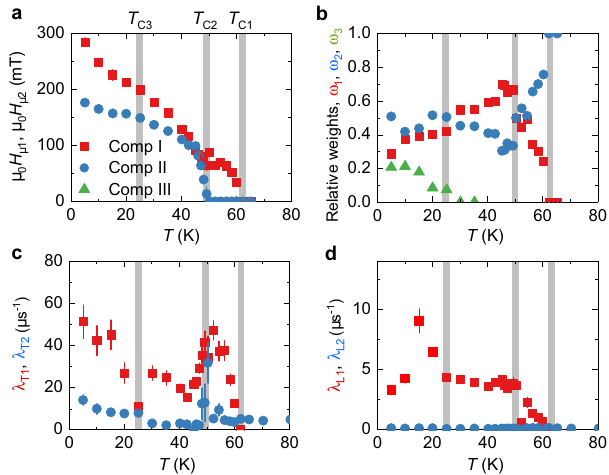
Fig. 2 Temperature dependent μ SR parameters. a The temperature dependence of the internal magnetic fi elds for the observed two components in CrI 3 . b The temperature dependence of the relative weights ω 1,2,3 of the three components in the total signal. c , d The temperature dependence of transverse depolarization rates λ T 1 , λ T 2 and the longitudinal depolarization rates λ L 1 , λ L 2 for two components, respectively. The error bars represent the standard deviation of the fi t